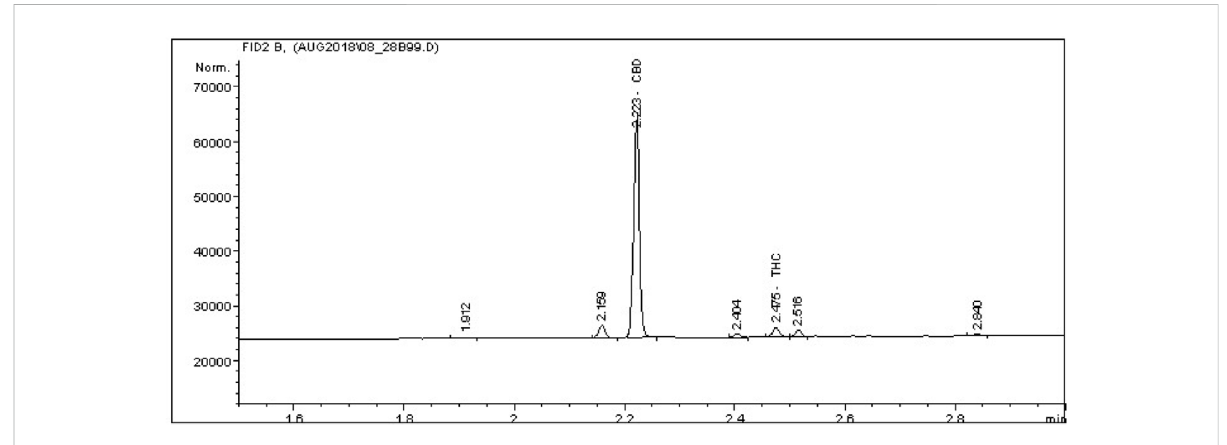
Calibration curves.